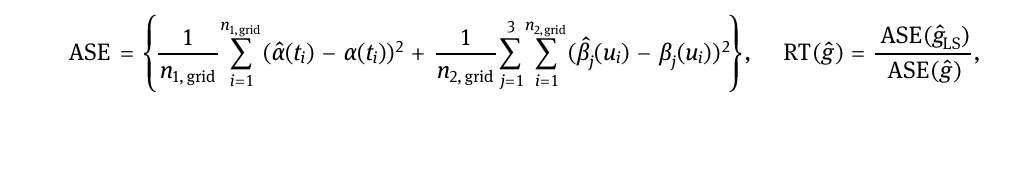
Table 1: Simulation results for comparison under